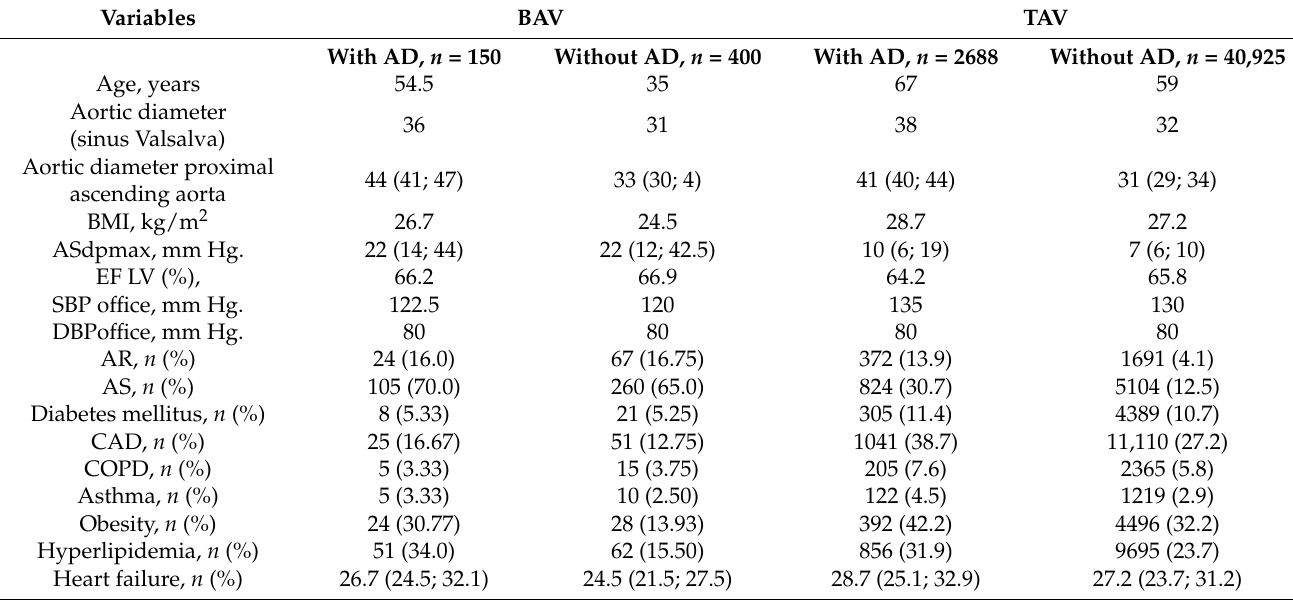
Table 4. Demographic and clinical characteristics of female